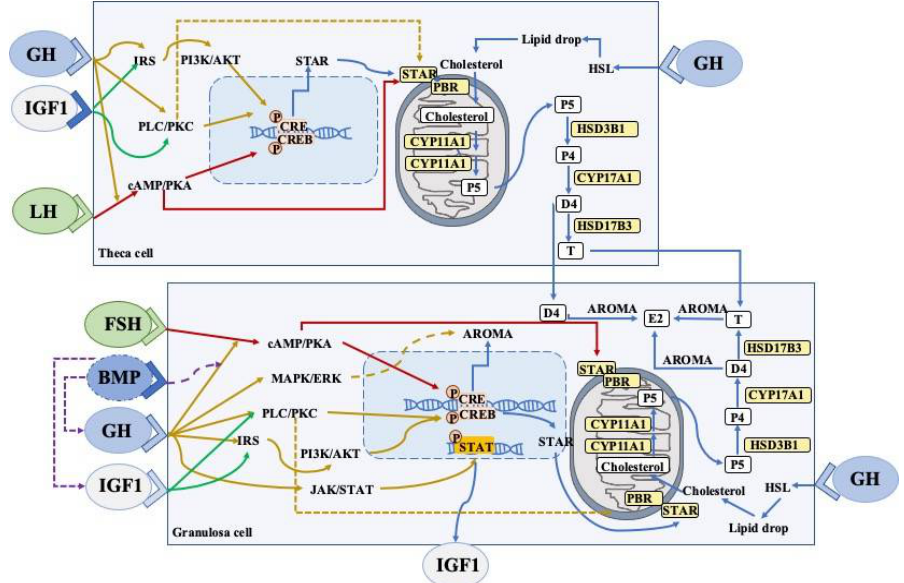
Figure 2. A schematic representation of the major GH/IGF signaling and BMP system networks in ovarian cells (theca and granulosa